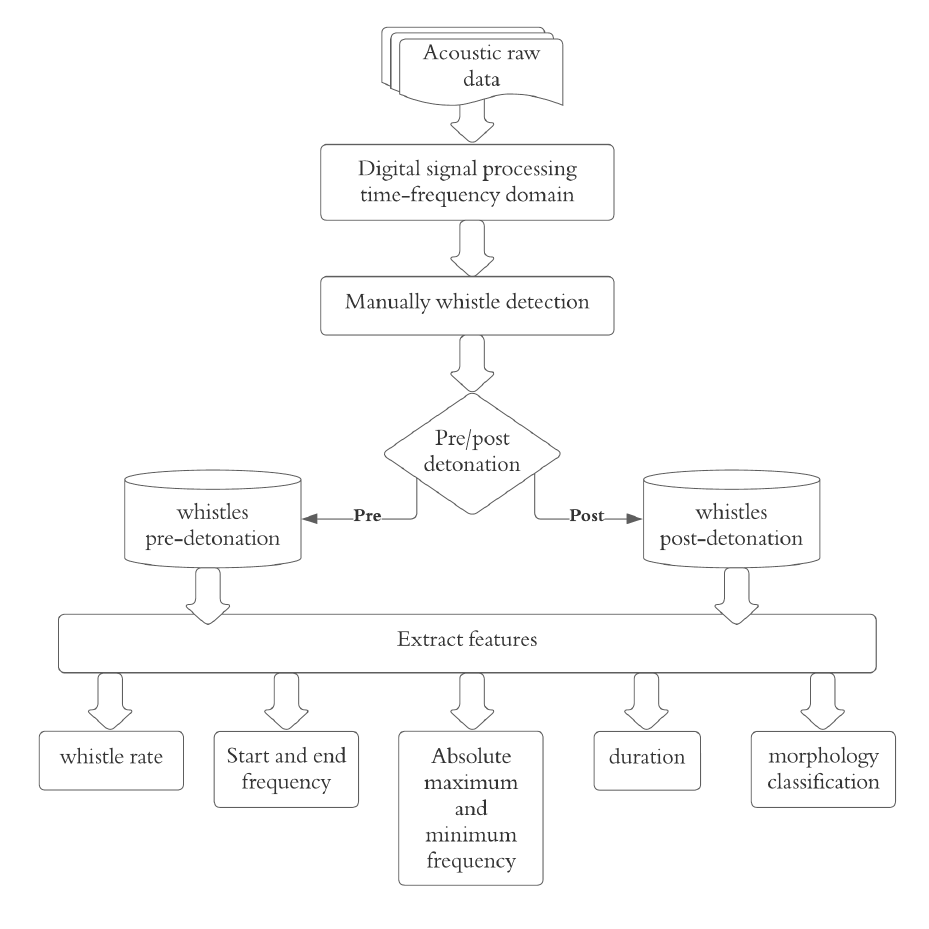
Figure 5. Analysis workflow